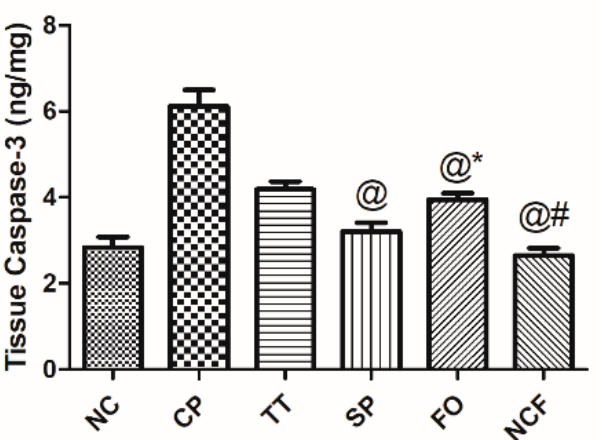
Figure 14. Effect of TT, SP, FO, and NCF on cisplatin-induced alterations in testicular caspase-3 in adult male rats. Effect of 20 days’ administration of TT (100 mg/kg/orally); SP (1000 mg/kg/orally); FO (400 mg/kg/orally); and new nutraceutical formula (NCF) at a dose of (4.4 g/kg/orally) on testicular content of caspase in CP-untreated rats. Values are means of 6-10 rats ± SD. Statistical analysis was performed using one-way ANOVA followed by Newman Keuls multiple comparison tests ( p < 0.05). As compared with normal control (NC; *), cisplatin (CP; @), Tribulus terrestris (TT; #). Spirulina platensis (SP), Fish oil (FO).